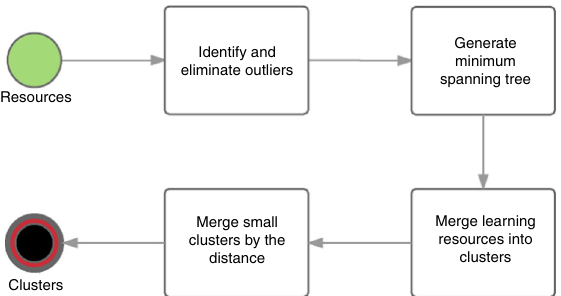
Figure 1. Framework of online learning resource